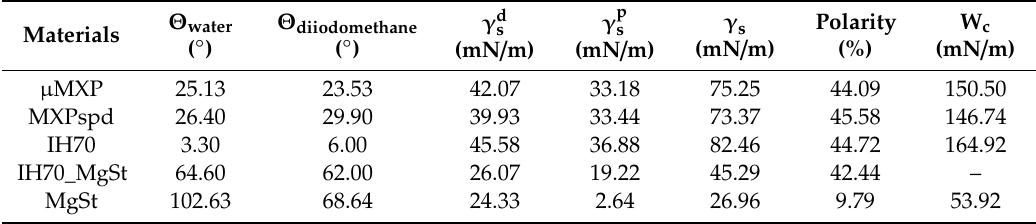
Table 3. Contact angles in the case of distilled water and diiodomethane, surface free energy and their components, polarity, and cohesion work of the applied material in the